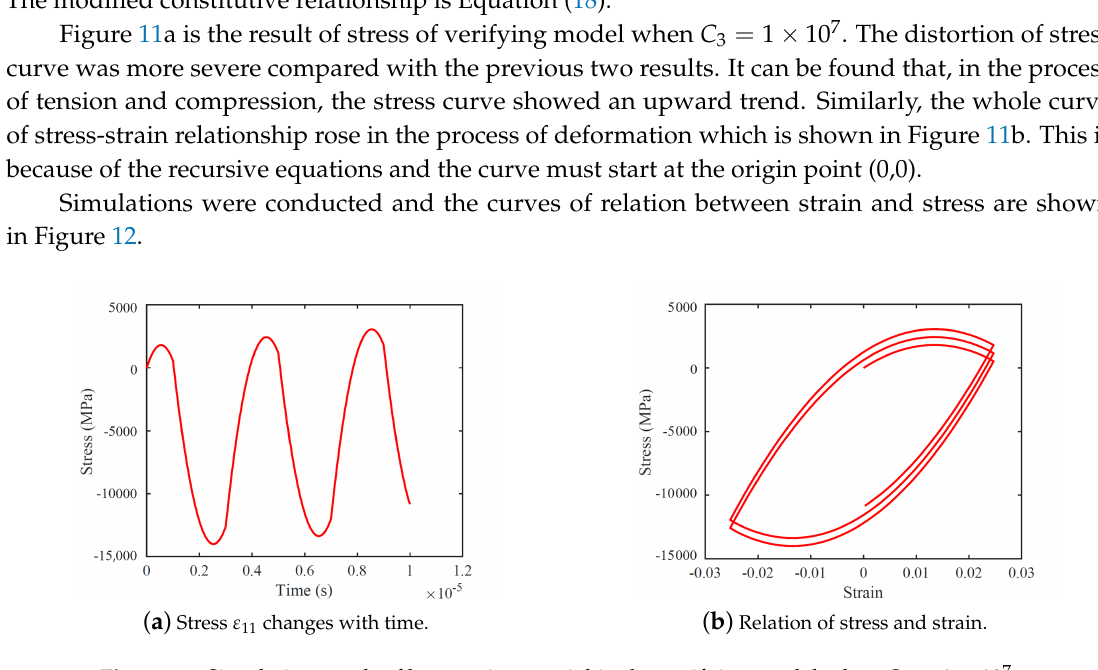
Figure 11. Simulation result of hysteretic material in the verifying model when C 3 = 1 × 10 7 .